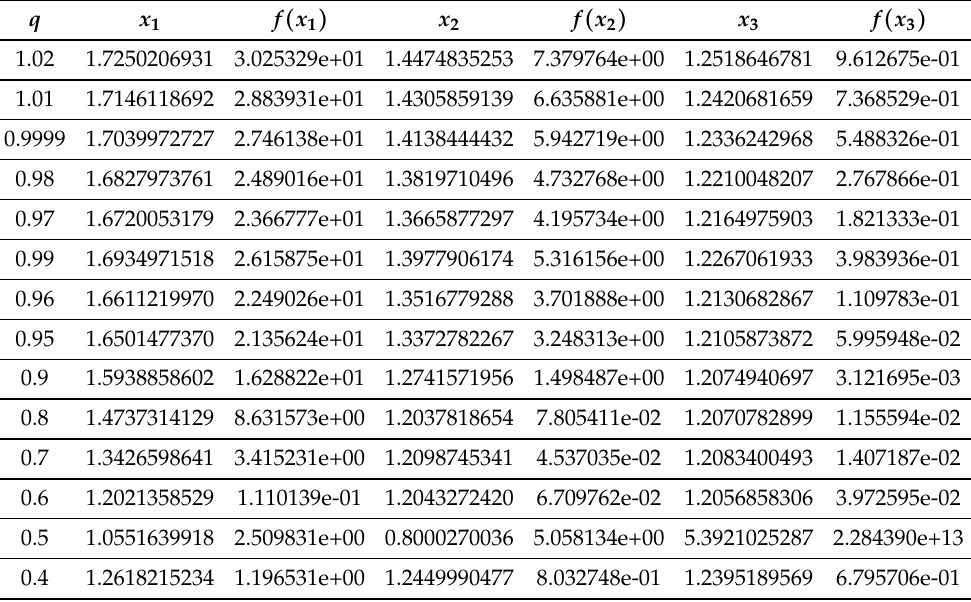
Table 1. Calculation of x i and f ( x i ) for i = 1,2,3 and different values of q by using QAG 1.